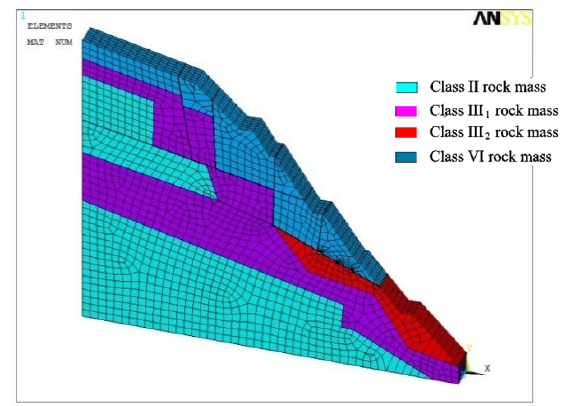
Figure 15. Two-dimensional numerical calculation grid graph of the slope.